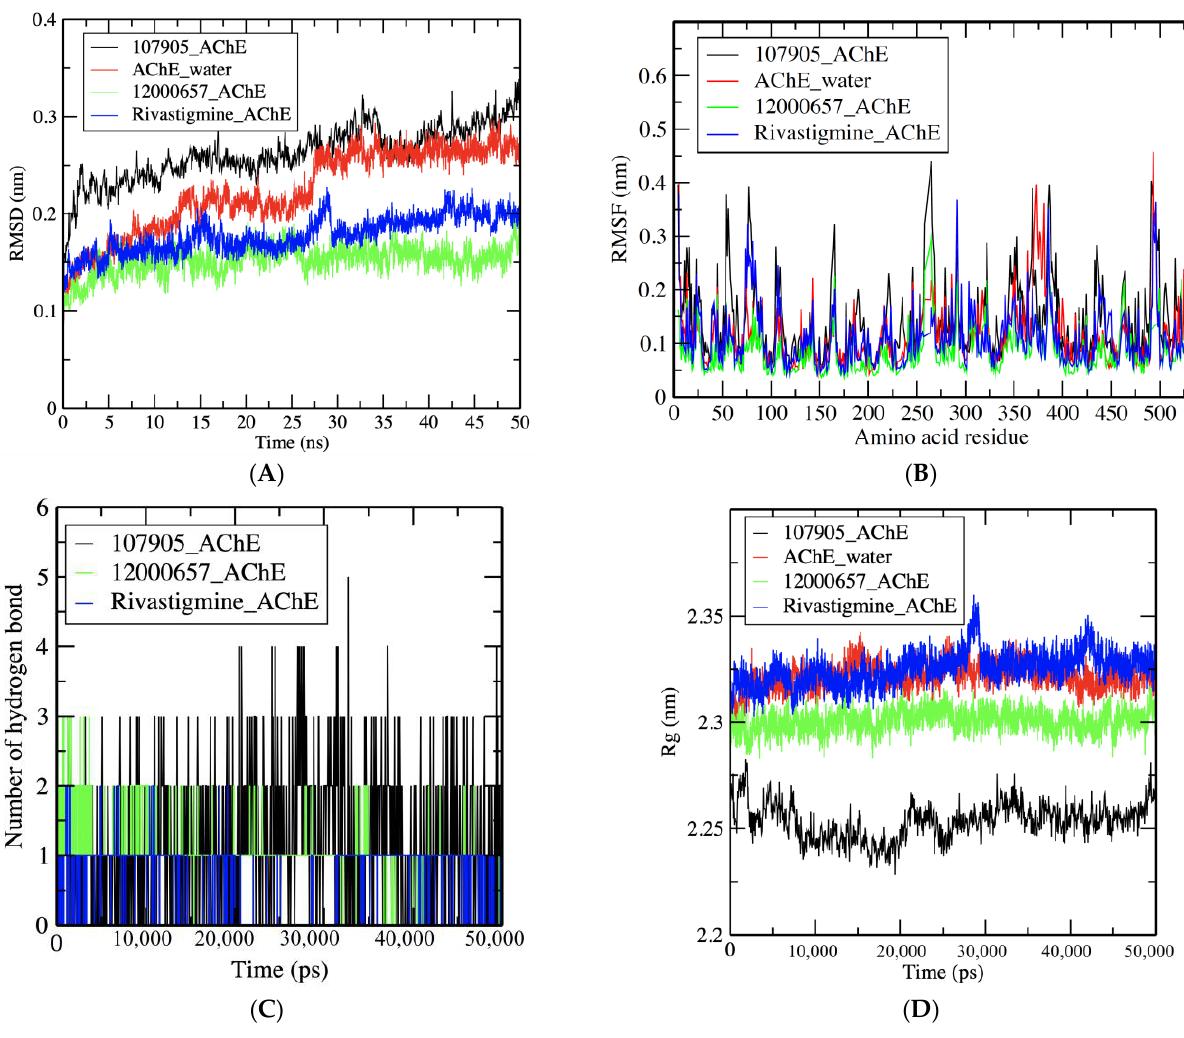
Figure 3. ( A ) RMSD plot of 107905–AChE (black), AChE in water (red), 12000657–AChE (green), and control drug rivastigmine–AChE (blue) complexes. ( B ) RMSF values of the enzyme and compound complexes per amino acid residue. ( C ) Number of hydrogen bonds formed between compounds and AChE in 50,000 ps. ( D ) Rg values that show the compactness of AChE and compounds complexes maintained for the whole simulation period.